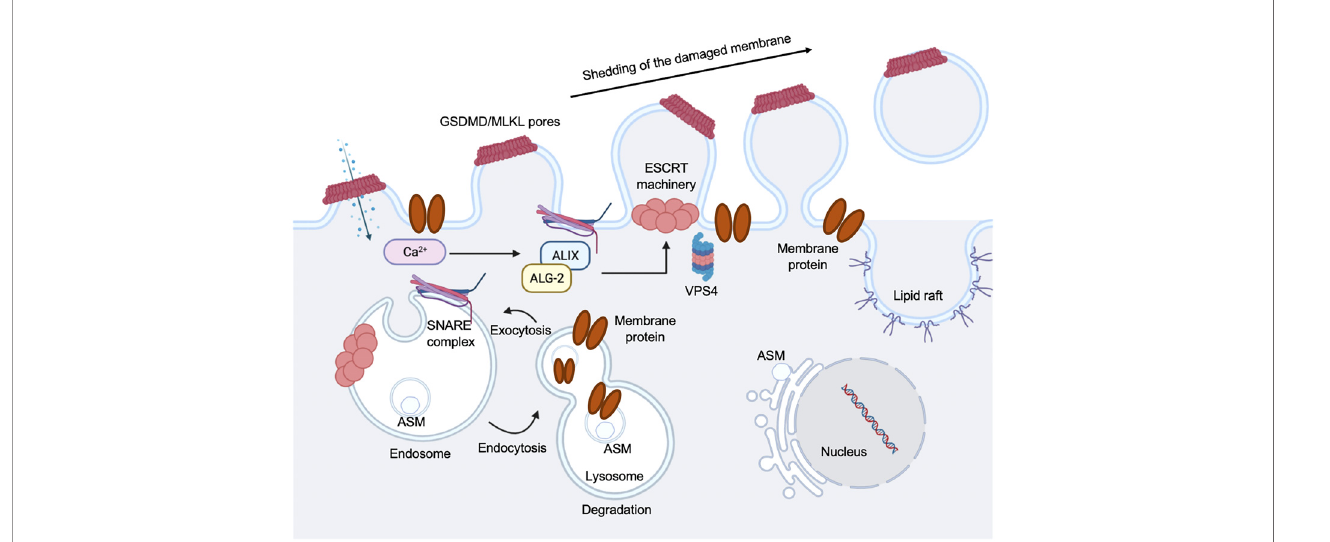
FIGURE 7 | Regulation of pyroptosis membrane repair mechanisms. Pyroptotic pores formed by GSDMD, or necroptotic pores formed by mixed lineage kinase domain- like protein (MLKL), triggers ion exchanges across the plasma membrane. Ca 2+ in fl ux occurs through plasma membrane wounds, which in turn binds to apoptosis linked gene 2 (ALG-2) facilitating its recruitment and migration to the damage site. Elevation in the intracellular Ca 2+ concentration triggers exocytosis of lysosomes. Lysosomal acid sphingomyelinase (ASM) is transported to the outer lea fl et of the membrane. This is followed by the recruitment of ALG-2 interacting protein X (ALIX) and this occurs in an ALG-2 and Ca 2+ dependent manner. This initiates ESCRT-III assembly, leading to membrane deformation into the extracellular milieu. A promising candidate is SNARE-mediated exocytosis to facilitate vesicle and plasma membrane fusion events. Vacuolar protein sorting-associated protein 4 (VPS4) leads to membrane repair and shedding of the damaged part of the cell membrane, recycling ESCRT subunits during this